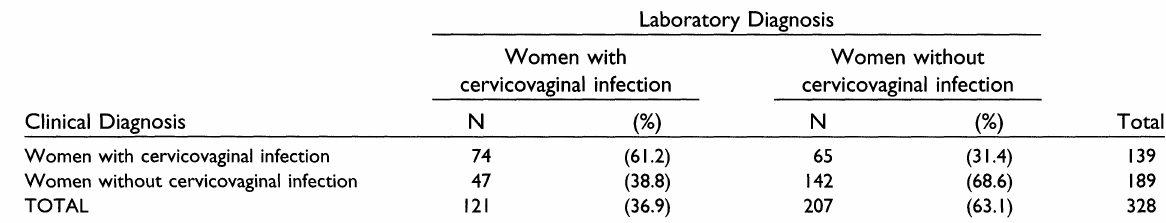
Laboratory Diagnosis Women with